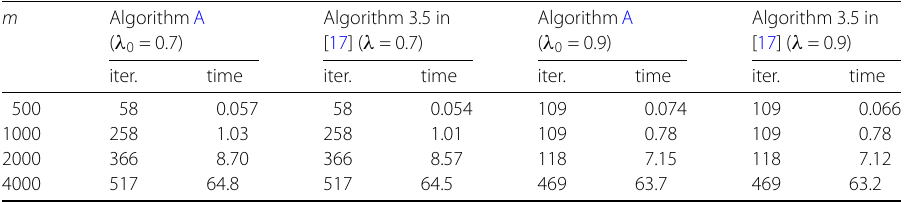
Table 2 Comparison between Algorithm A and Algorithm 3.5 in [17] m AlgorithmA ( λ 0 =